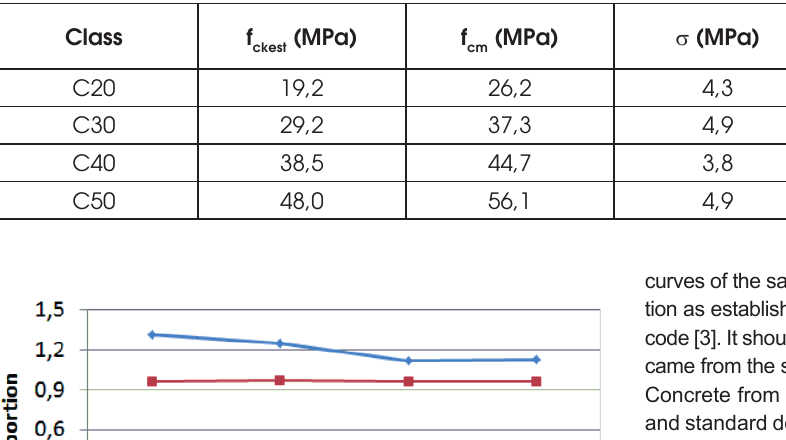
Results of the concrete produced in Brazil